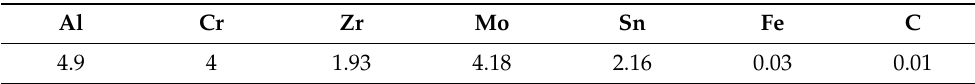
Table 3. Chemical composition of TC17 (wt.%).